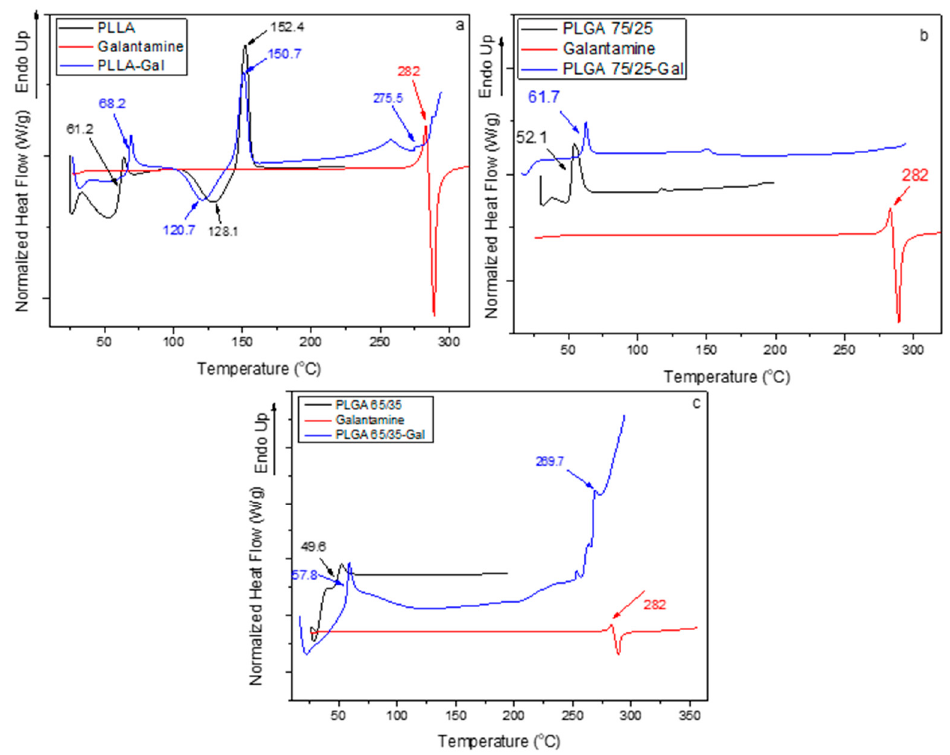
Figure10. DSCthermographsofneatpolymersandtheirnanoparticleswithgalantamine( a )PLLA–GAL, Figure 10. DSC thermographs of neat polymers and their nanoparticles with galantamine ( a ) PLLA– ( b ) PLGA 75 / 25–GAL, and ( c ) PLGA 65 / GAL, ( b ) PLGA 75/25–GAL, and ( c ) PLGA 65/35–GAL.